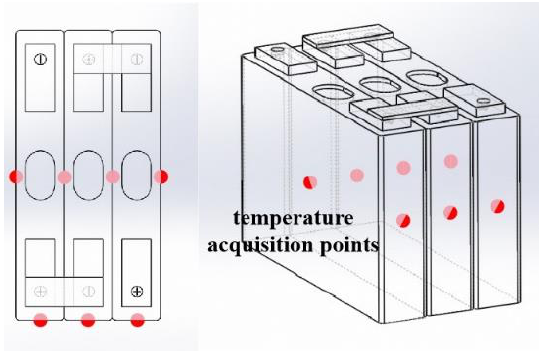
Figure 7. Curves of parameters R condx and R condy.